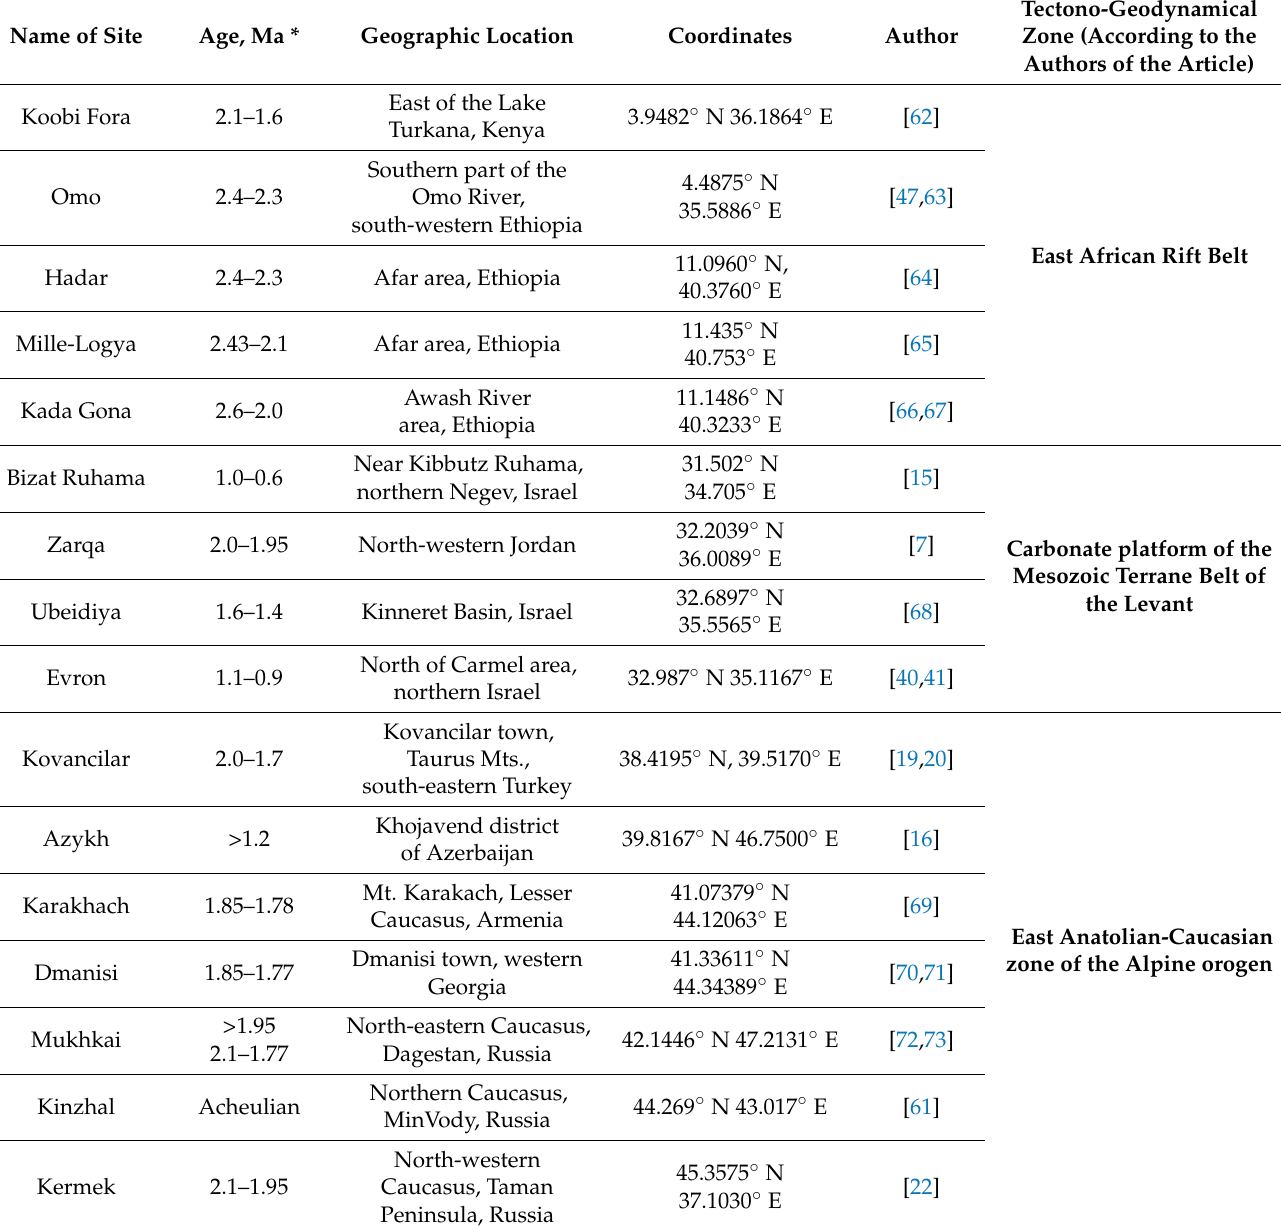
Table 1. Location and age of the well-studied African-Levantine-Caucasian anthropological